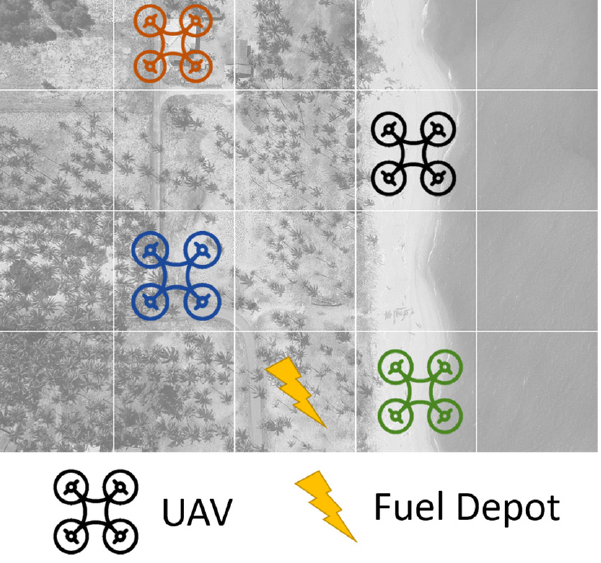
Figure 3. In the UAV simulation (at one-tenth of the scale), the agent team must navigate to each unique map location to maximize the UAV survey task. Fuel depots allow the UAVs to recharge their batteries when they land and execute a refuel action.